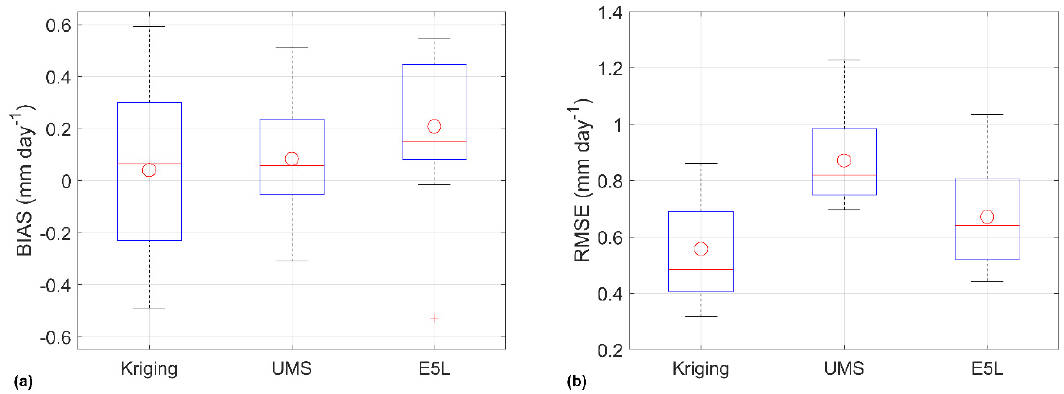
Figure 5. ( a ) BIAS and ( b ) RMSE of ET 0 computed with weather data from kriging interpolation, UERRA MESCAN-SURFEX (UMS) and ERA5-Land (E5L). Spread of the box plots refers to the variability of the statistical indices among the 18 AWS sites. Circles indicate the mean values. Central lines in the box indicate the median, the box edges are drawn at the 25th (p 25 ) and 75th (p 75 ) percentiles. Whiskers extend to the most extreme data values, excluding the outliers. Values are considered as outliers when larger than p 75 + 1.5(p 75 − p 25 ) or smaller than p 25 − 1.5(p 75 − p 25 ).